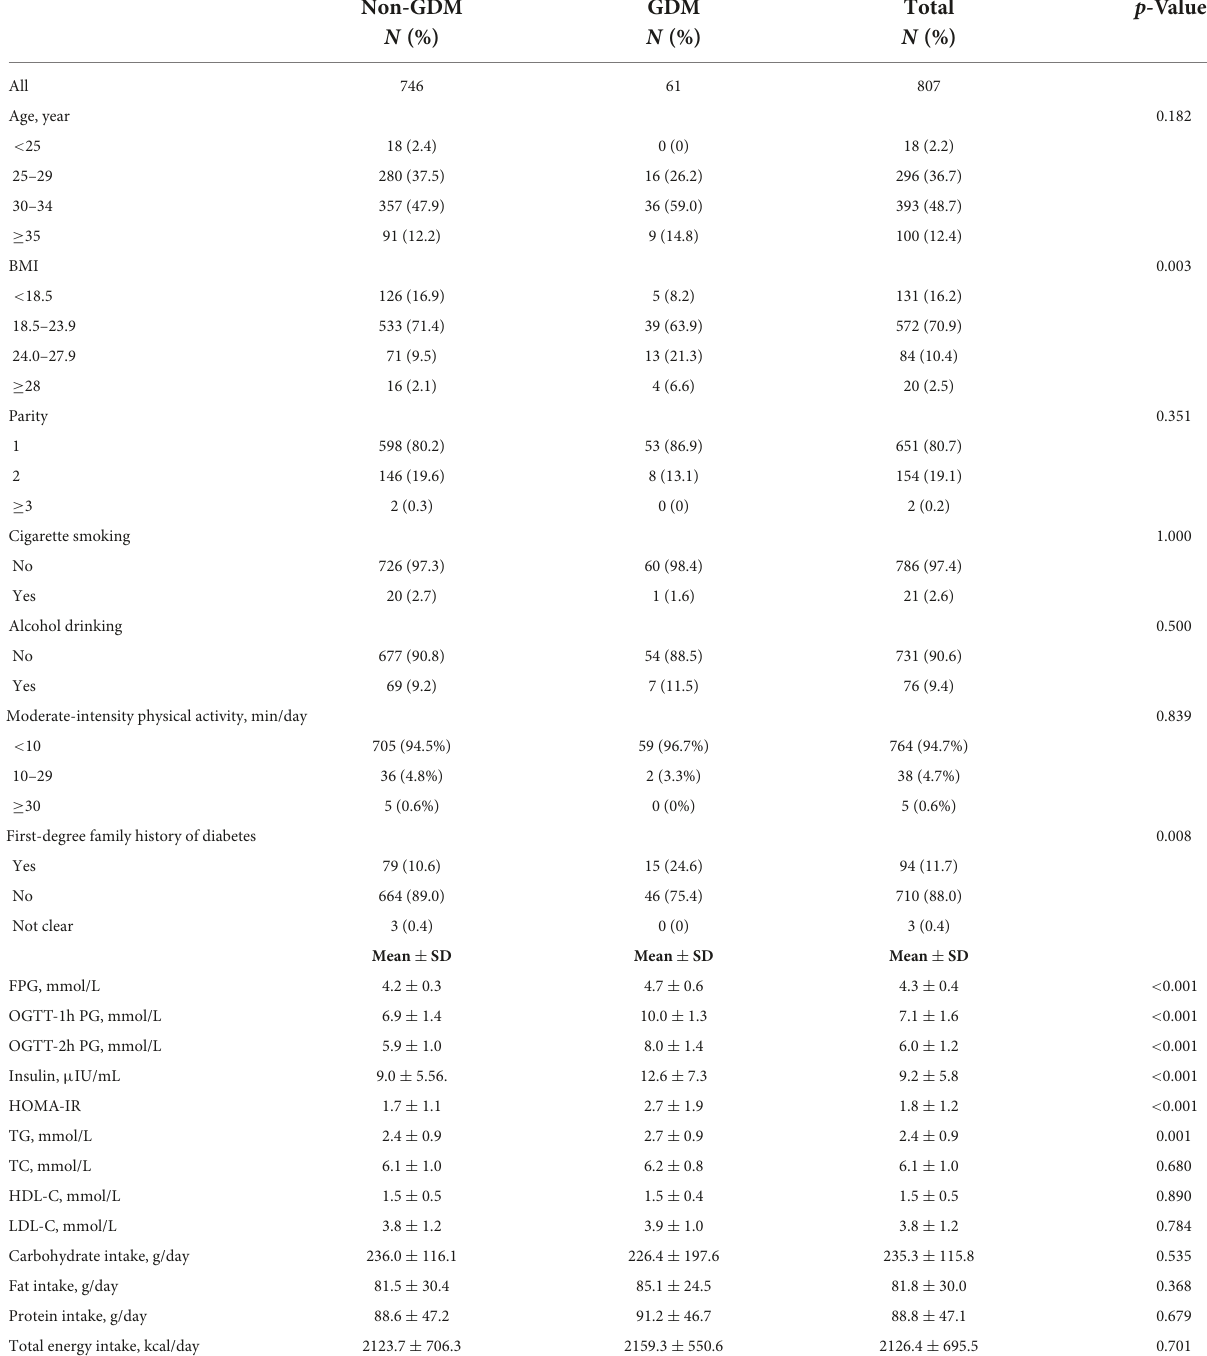
TABLE 1 The basic characteristic of the participants in the cross-sectional study by GDM